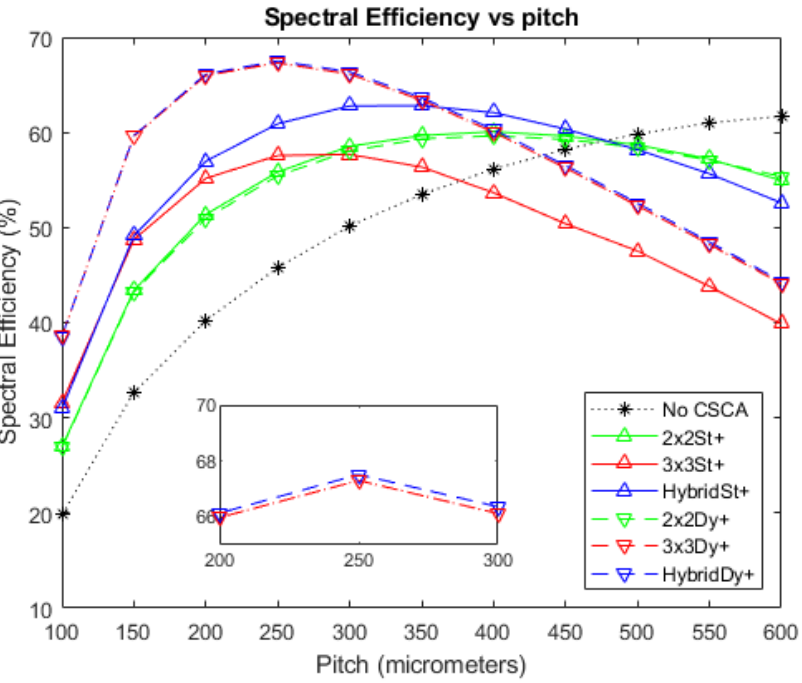
Figure 12. A plot of BSE versus pixel pitch at an incident photon flux of 10 7 photons mm −2 s −1 . The dynamic Hybrid and dynamic 3 × 3 CSCAs perform exceptionally closely according to this metric (see inset), resulting in significant overlap. The same is true for the dynamic 2 × 2 and static 2 × 2 CSCAs. The case where no CSCA is applied is also shown as a reference.